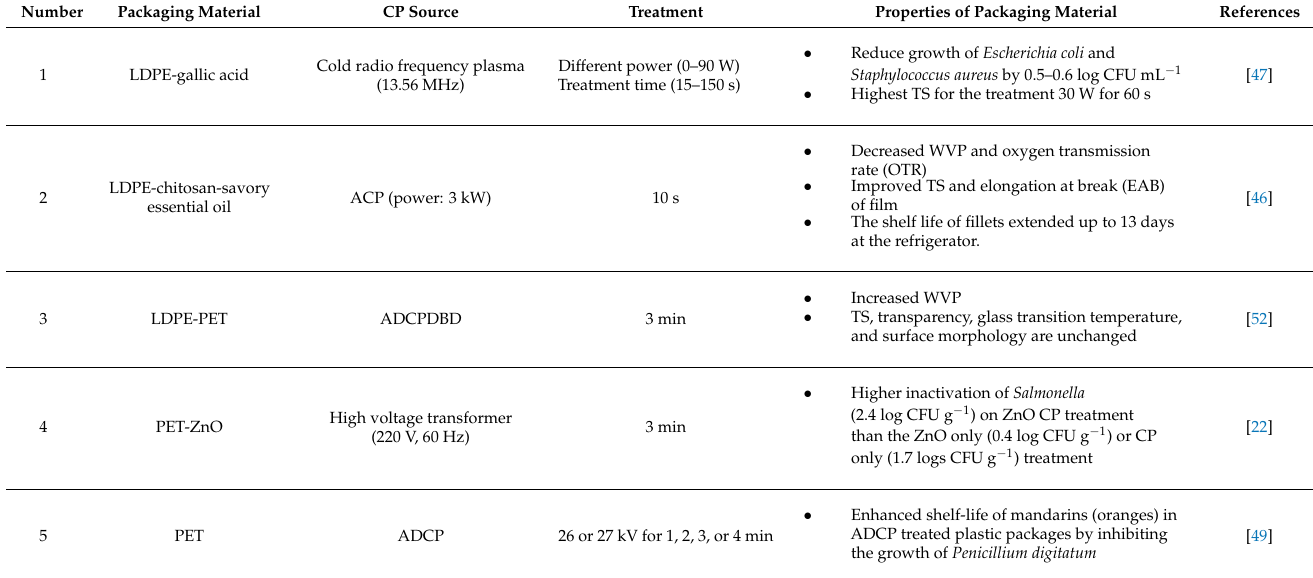
Table 2. Impact of CP on modification of food packaging